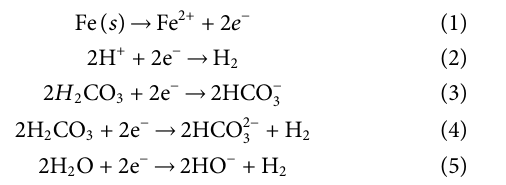
FIGURE 1 | Microstructure of N80